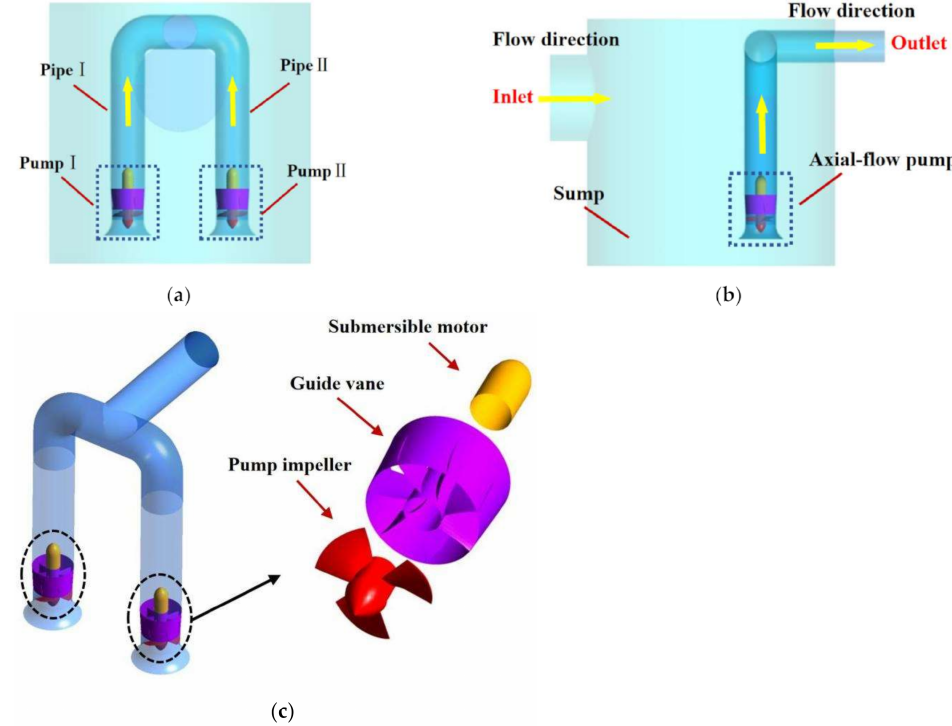
Figure 2. The structure of the prefabricated pumping station model. ( a ) Front view of the model; ( b ) Side view of the model; ( c ) Structure of the submersible axial-flow